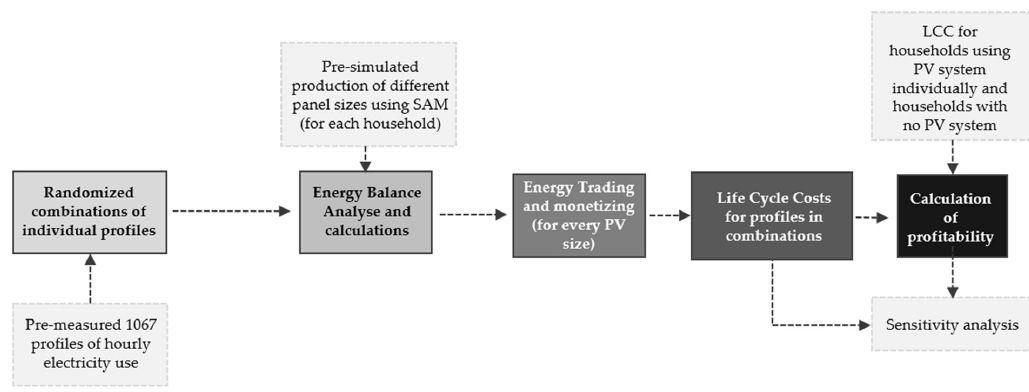
Figure 1. Methodology